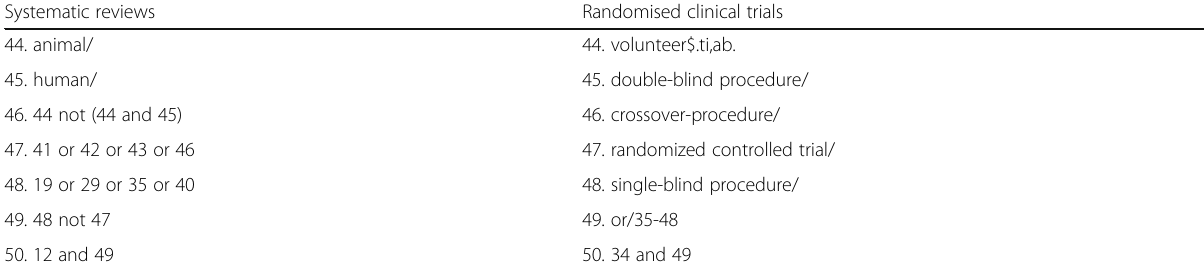
Table 2 Searches to identify systematic reviews and potentially eligible trials (MEDLINE via Ovid)